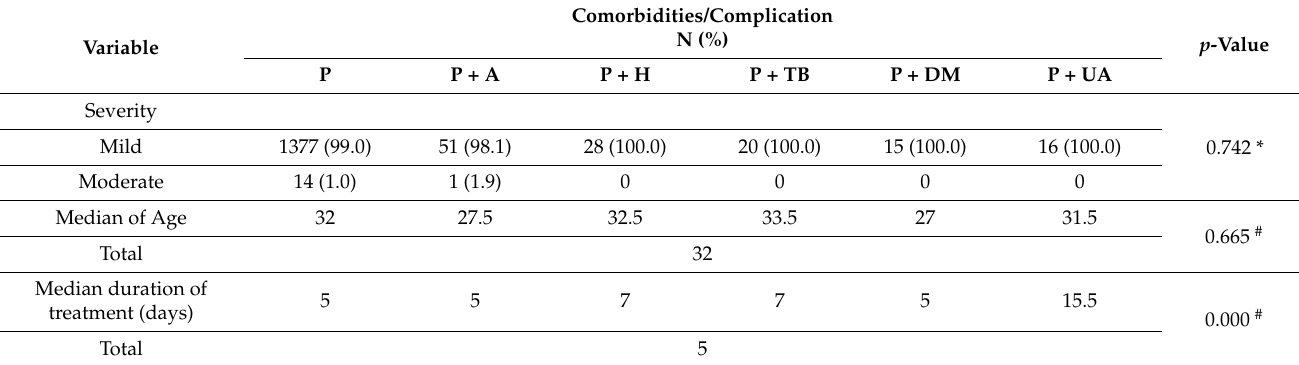
Table 3. Correlation between comorbidities/complications and